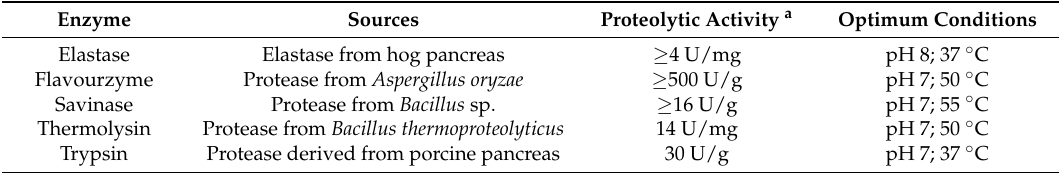
Figure 1. Degree of hydrolysis of casein hydrolysed under different conditions. ( a ) under atmospheric (0.1 MPa) and different high hydrostatic pressures (HHP, 50, 100, and 200 MPa) hydrolysed with different enzyme treatments at an enzyme-to-substrate (E:S) ratio of 1:50 for 1h; ( b ) different incubation times (15 and 30 min, 1 and 2 h) at an E:S ratio of 1:50 under 100 MPa; ( c ) at E: S ratios of 1:25, 1:50, 1:100, and 1:200 under 100 MPa for 1 h. Error bars are expressed as mean ± standard error with n ≥ 3. In each graph, the bars with different lowercase letters represent significant differences ( p < 0.05) in degree of hydrolysis (DH) values. Table 1. Enzymes applied in high hydrostatic pressure combined with enzymatic hydrolysis (HHP-EH) and atmospheric hydrolysis, and the operational conditions.